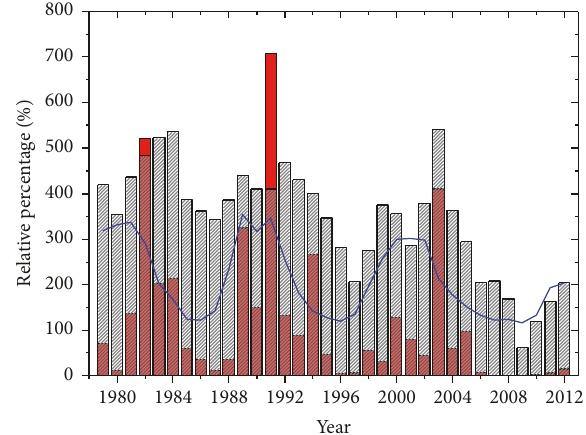
Figure 2: The annual-mean EI (Energy Index, see it in Section 2.3) anomalies of 𝐴 𝑝 (histograms) and 𝐹 10.7 (blue line) indices relative to 𝐴 𝑝 = 5 and 𝐹 10.7 = 60, respectively. The red and shadow columns denote 𝐴 𝑝 -HSSWS and 𝐴 𝑝 -CME,